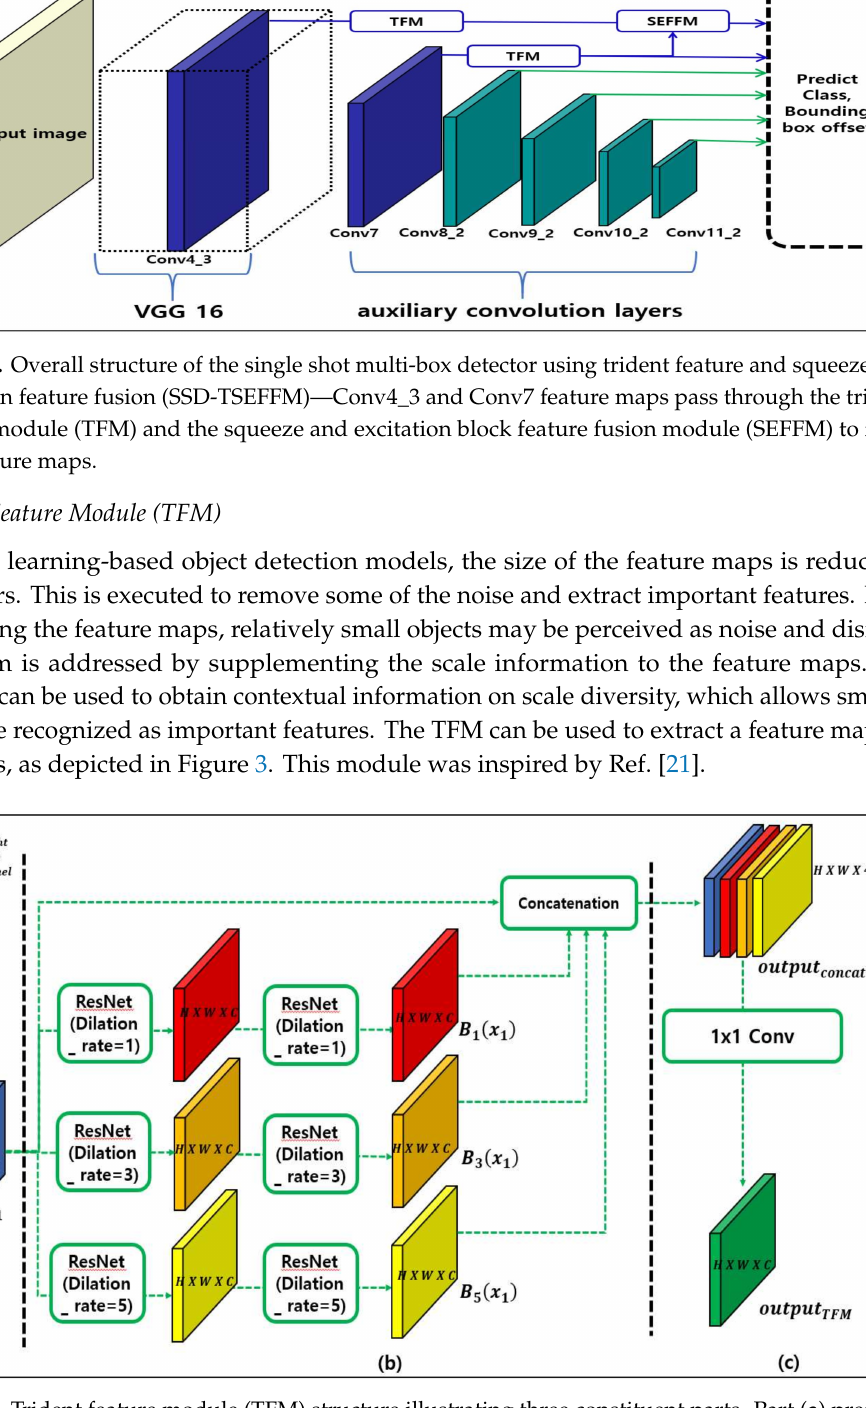
Figure 3. Trident feature module (TFM) structure illustrating three constituent parts. Part ( a ) presents the input feature map. Part ( b ) includes ResNet blocks with di ff erent dilation rates and concatenation. Part ( c ) illustrates the process of deriving the